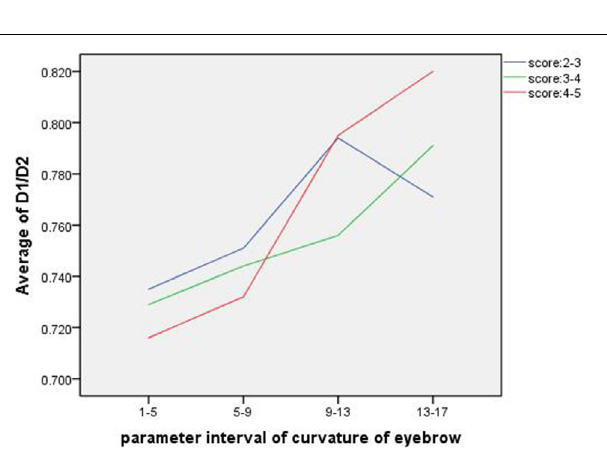
FIGURE 13 | The D1/D2 of the longitudinal axis is the average value in each eyebrow curvature parameter interval. The three curves show the relationship of the two between the attractiveness score intervals in 2–3, 3–4, and 4–5,